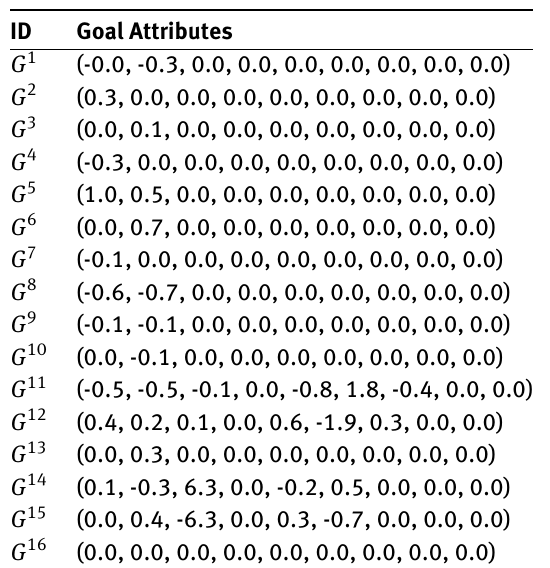
Table 5: Achievement goal prototypes generated in the first run of experiment 2 with ρ A = 0.7. Weights are rounded to 1 decimal